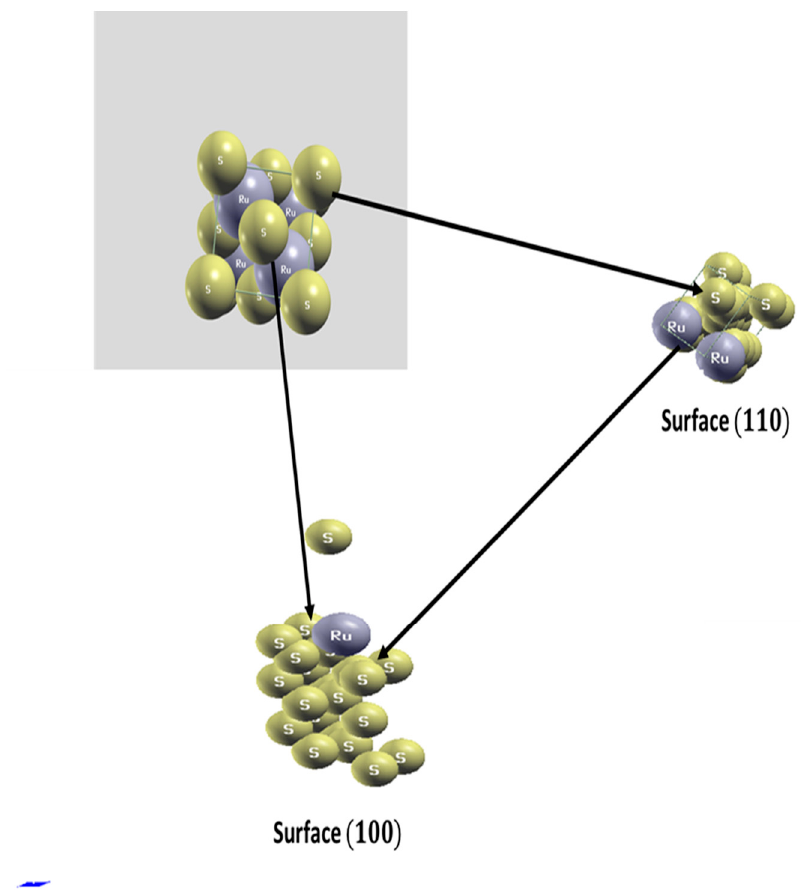
Figure 8. Distribution of sulfur in the surface (100) and the surface (110) of the pyrite RuS 2 .